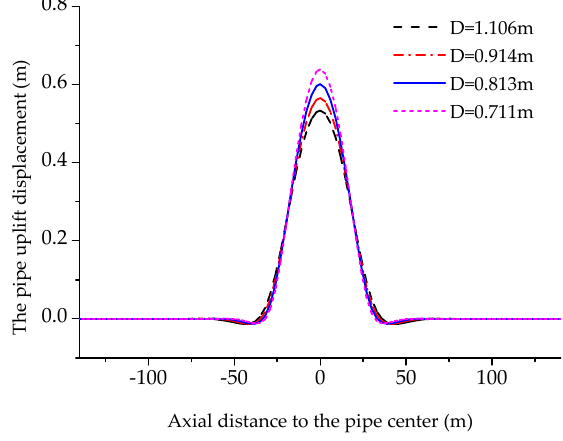
Figure 11. Vertical deformations for pipes with various diameters.